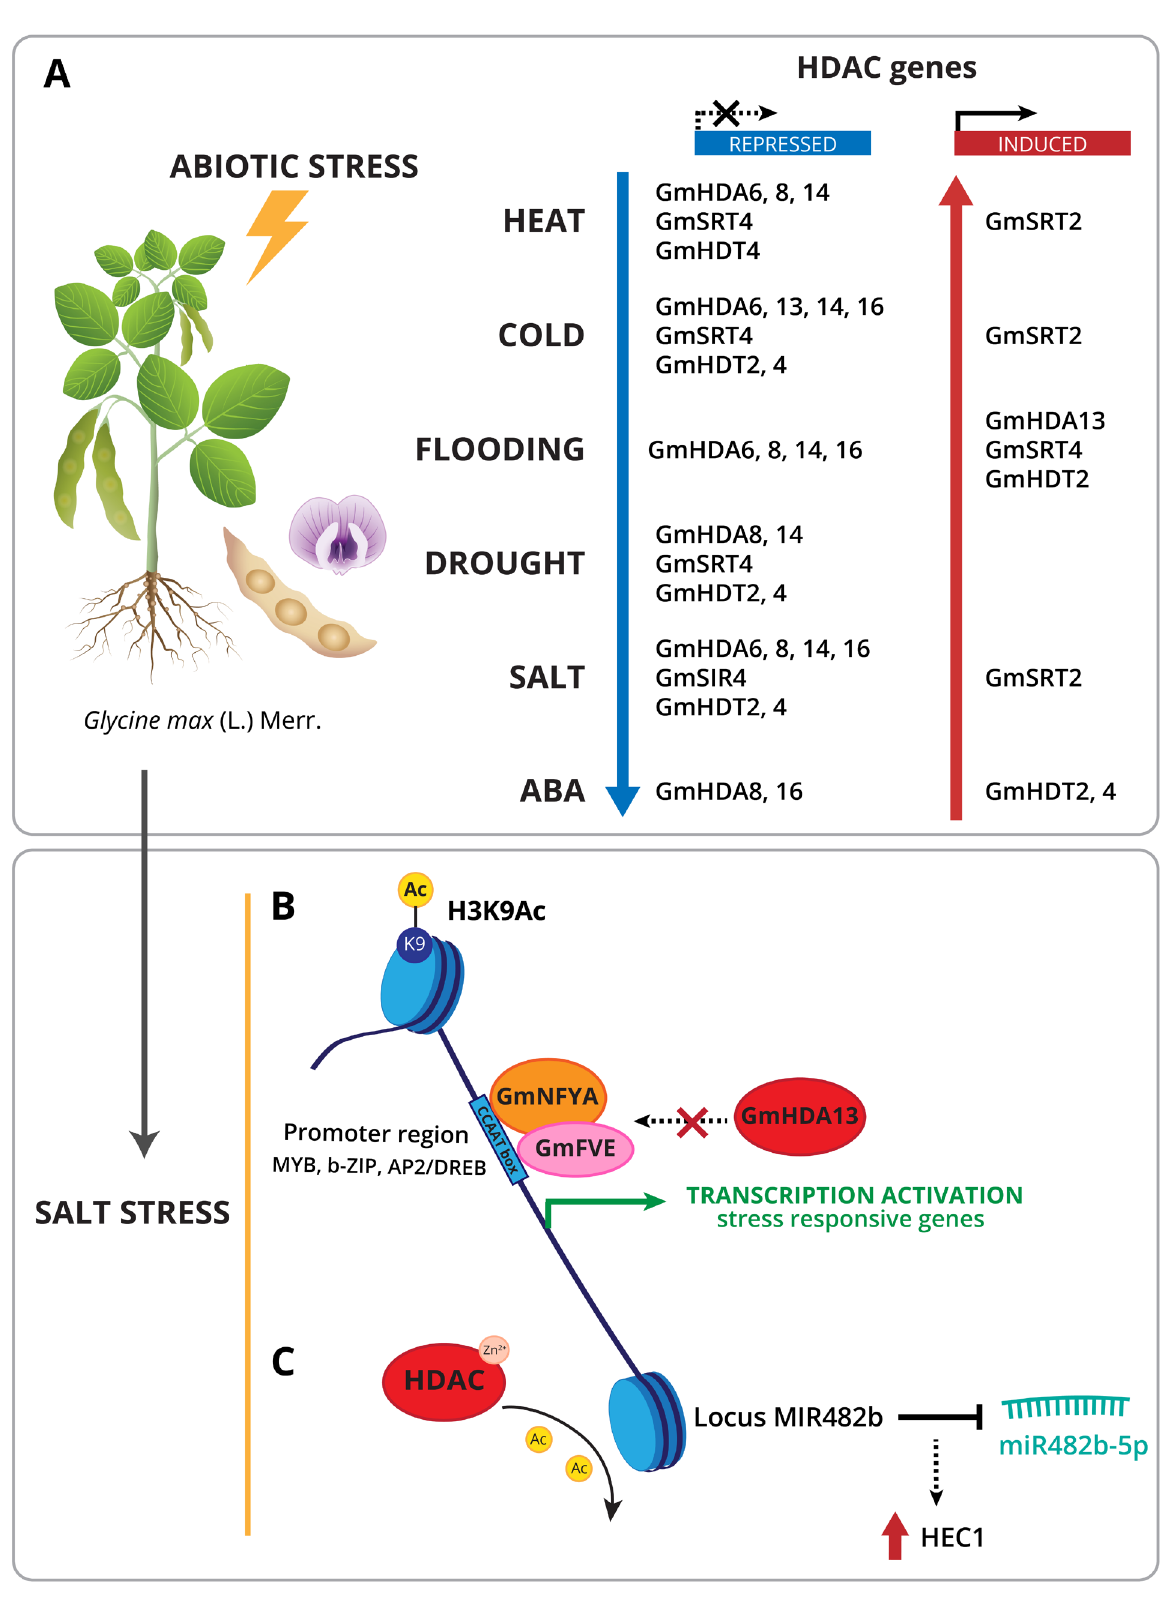
Figure 3 – Histone acetylation/deacetylation as epigenetic regulators in soybean under abiotic stress. (A) HDAC gene expression under multiple stresses can be either up or downregulated. Under salt stress: (B) acetylation H3K9Ac has been found in the promoter regions of stress responsive transcription factors (TF), such as MYB, b-ZIP, AP2/DREB. This epigenetic mark was correlated with their differential expression after stress. It has been proposed that GmNFYA forms a complex with GmFVE to bind CCAA box promoters, preventing HDA13 from reaching the promoter and preserving acetylation; (C) MIR482b gene expression is regulated by histone deacetylation, leading to the reduction of its expression and increasing its target gene (HEC1)